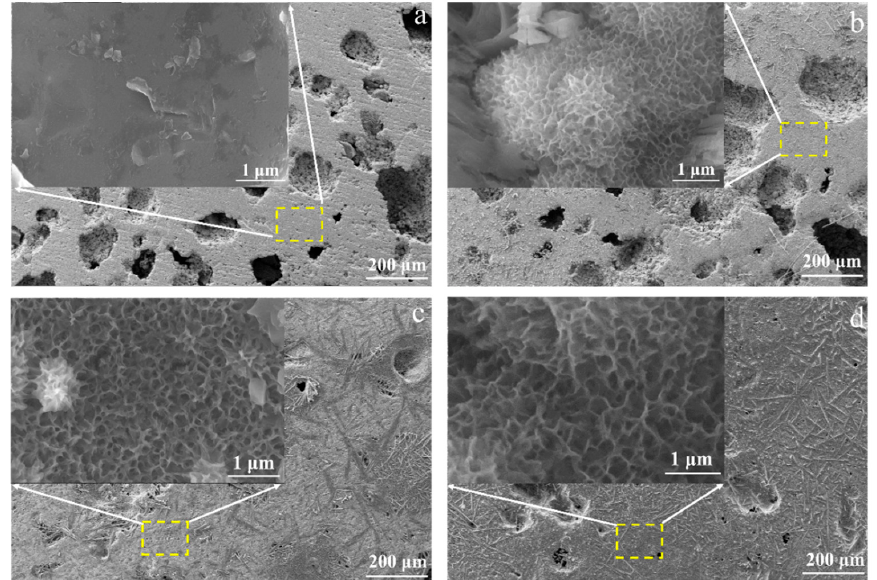
Figure 3. SEM morphologies of porous titanium treated with different concentrations of NaOH solutions: ( a ) Untreated porous Ti. ( b ) 5 M NaOH-treated porous Ti. ( c ) 10 M NaOH-treated porous Ti. ( d ) 15 M NaOH-treated porous Ti.